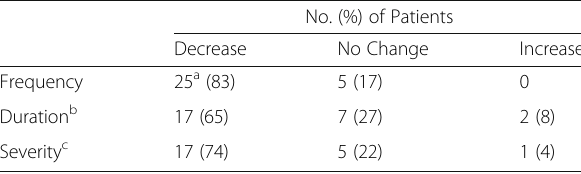
Table 3 Qualitative analysis of changes in CH attack frequency, duration, and severity with nVNS therapy